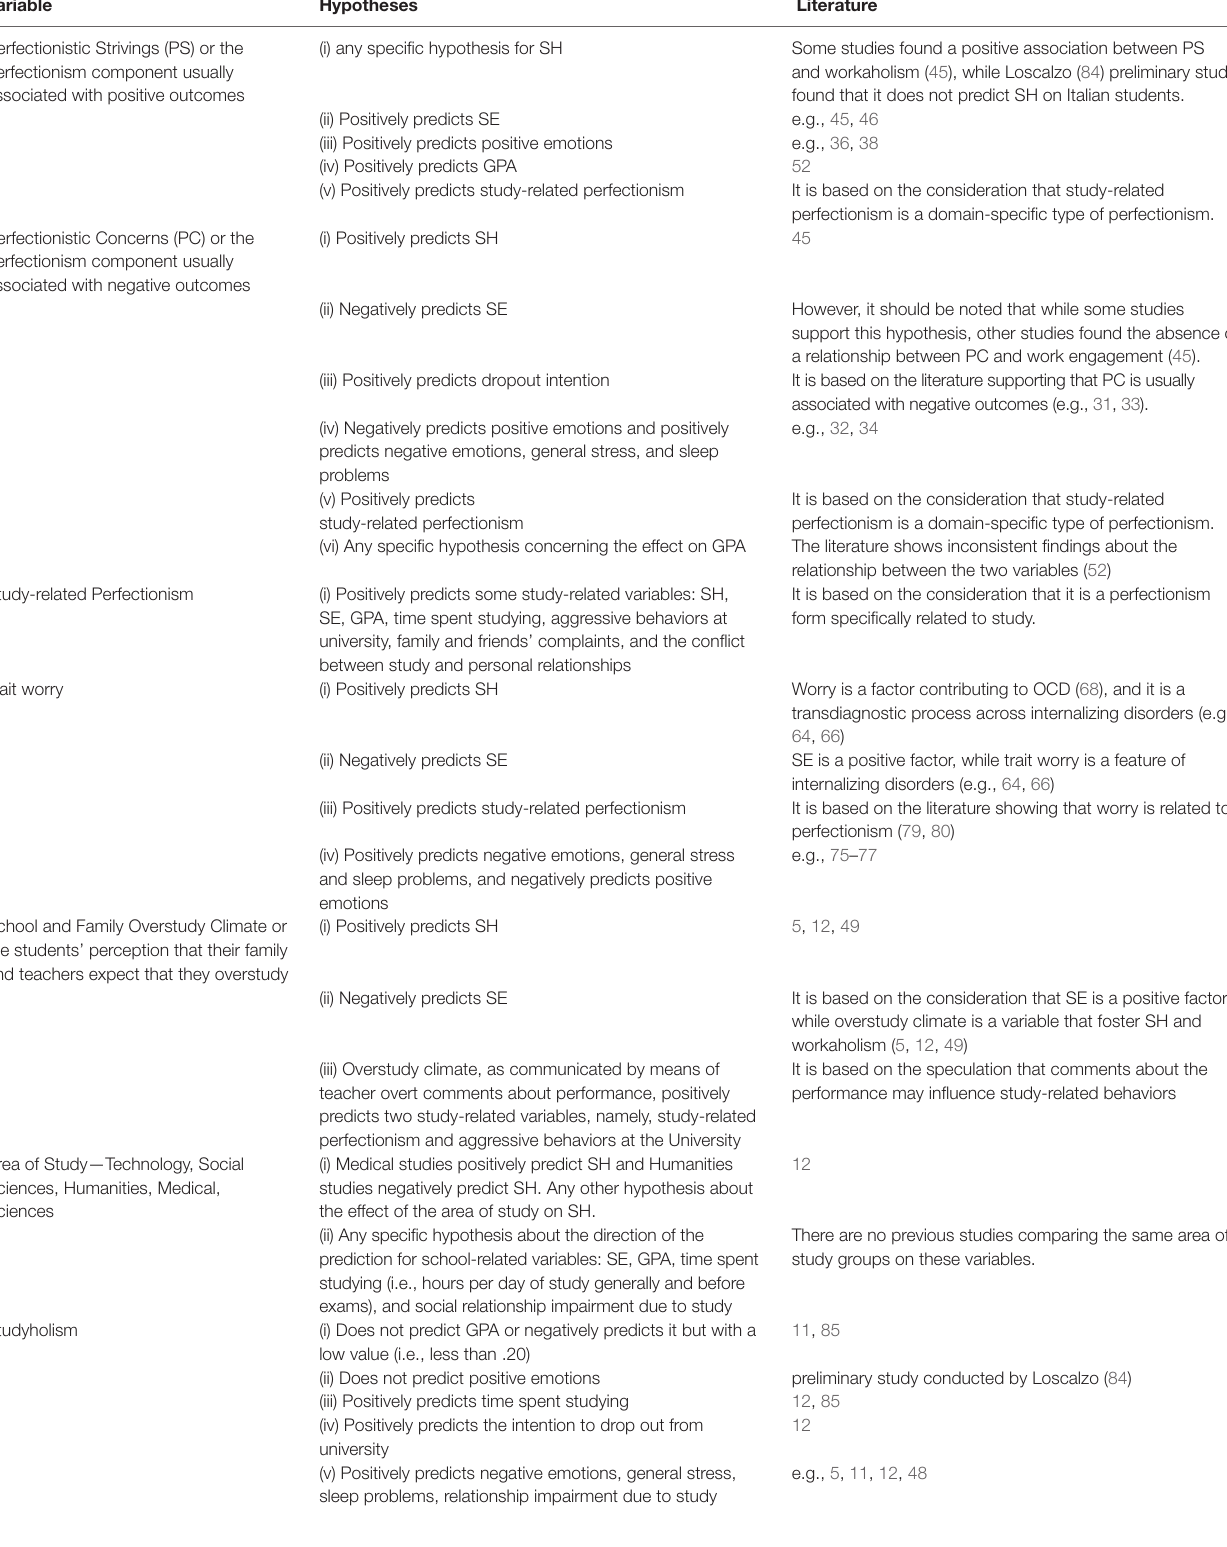
TABLE 2 | Hypotheses about the antecedents and the outcomes analyzed in the